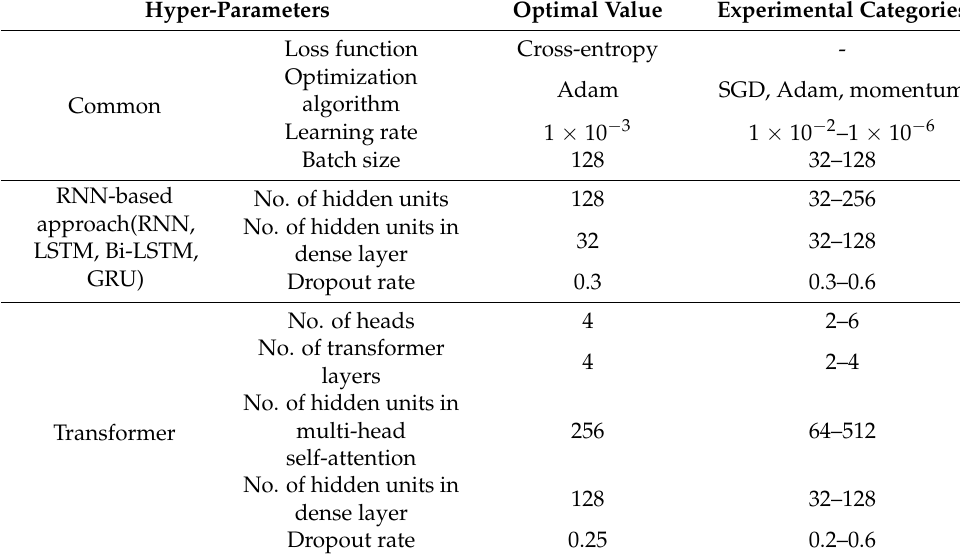
SGD: Stochastic Gradient Descent; RNN: recurrent neural network; LSTM: long short-term memory; BiLSTM: bidirectional long short-term memory; GRU: gated recurrent unit.